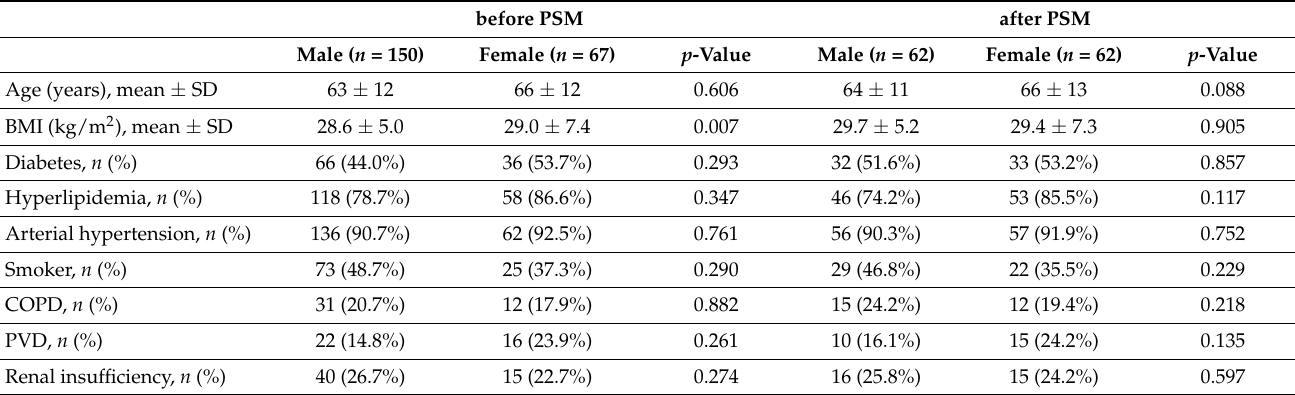
Table 1. Patient’s baseline preoperative demographics.